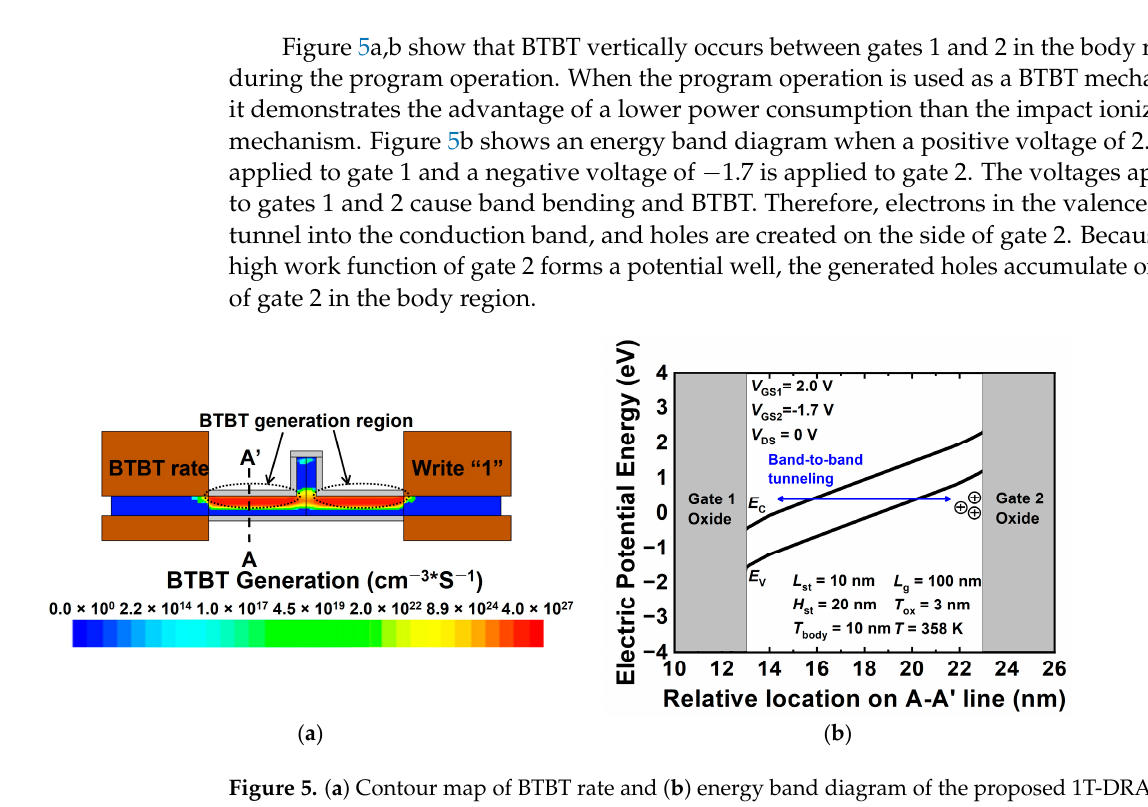
Figure 4. ( a ) Transient characteristics of proposed 1T-DRAM cell. ( b ) Variation of read currents in “1” and “0” states at different temperatures of 300 K and 358 K.